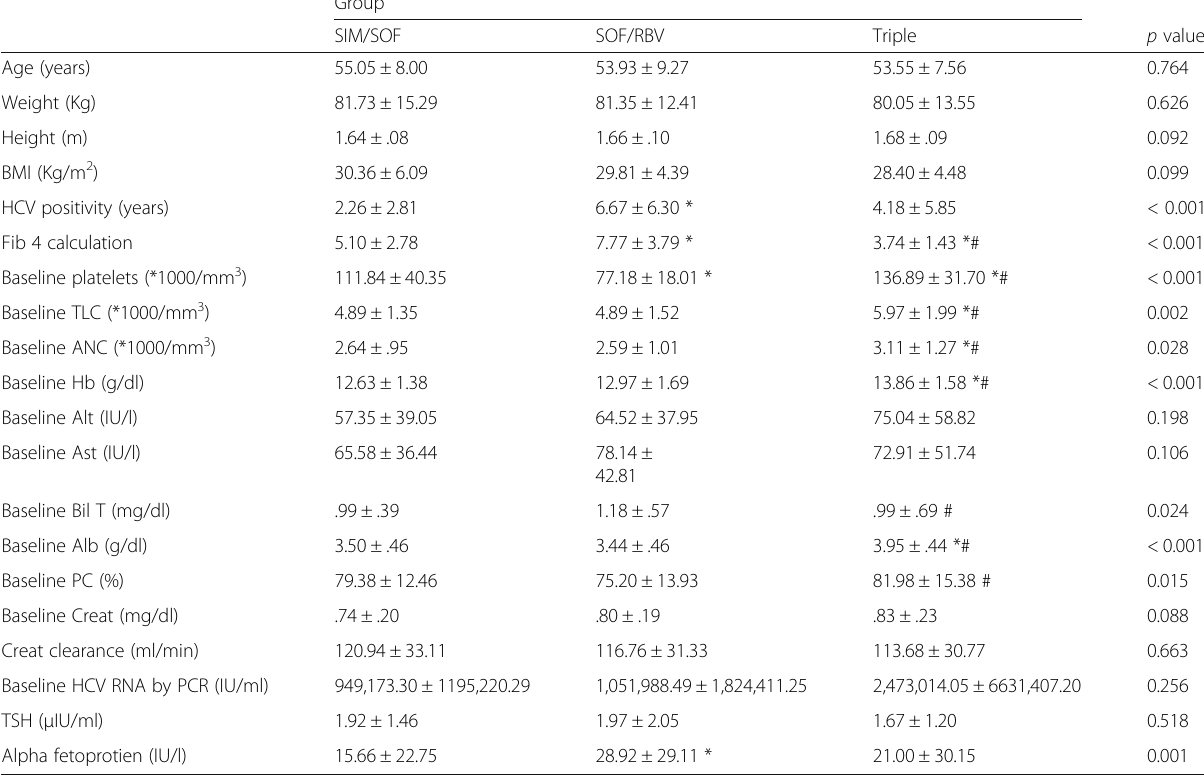
Table 2 Comparison of parameteric parameters of the three antiviral groups ( p >